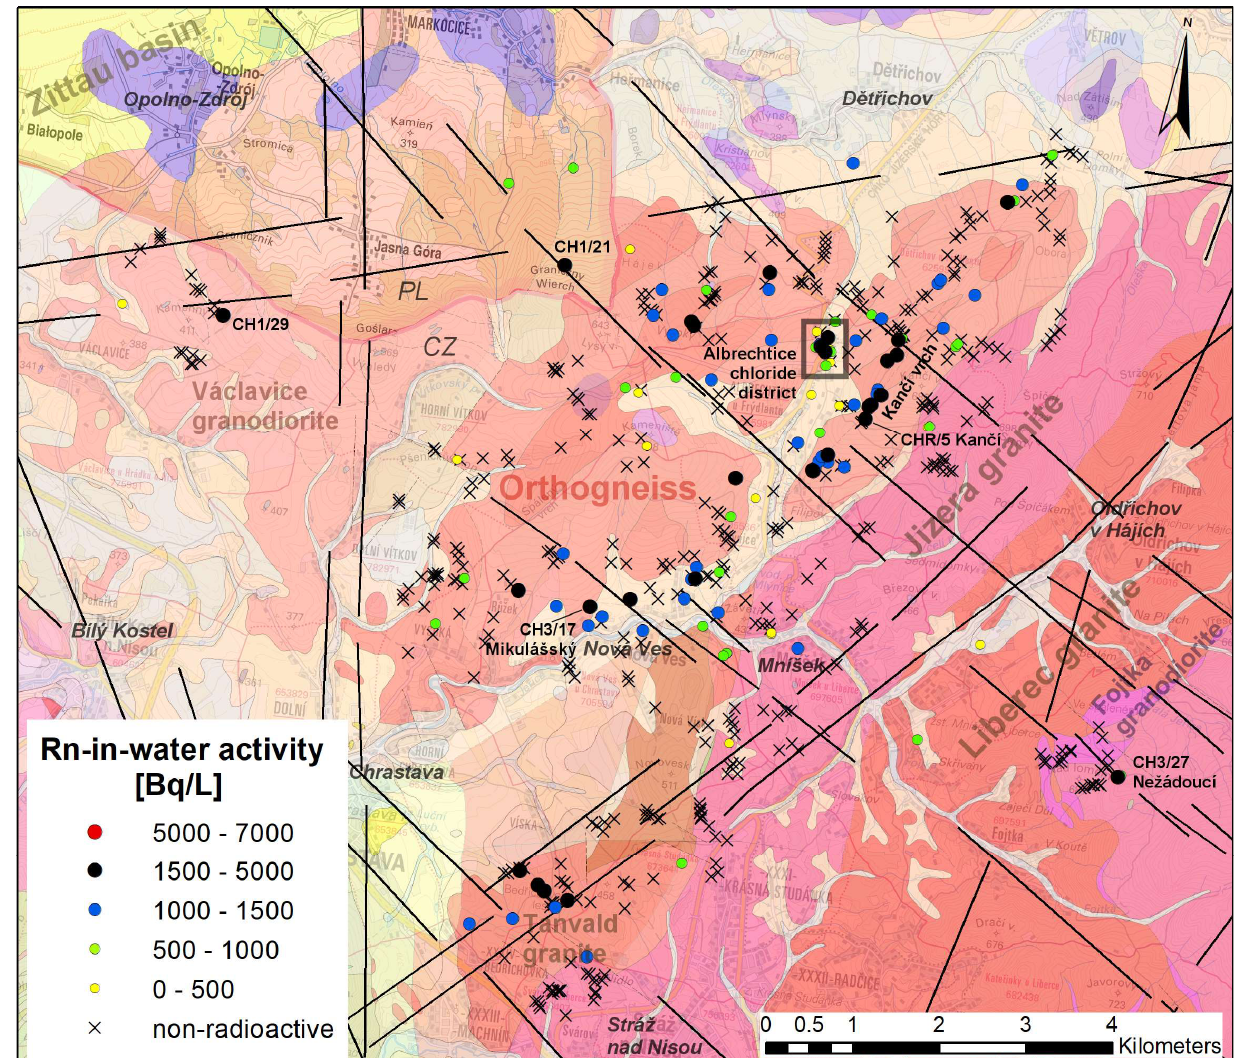
Figure 12. Radon-in-water activities in the Chrastava–Bogatynia area, Claim #4 (GIS